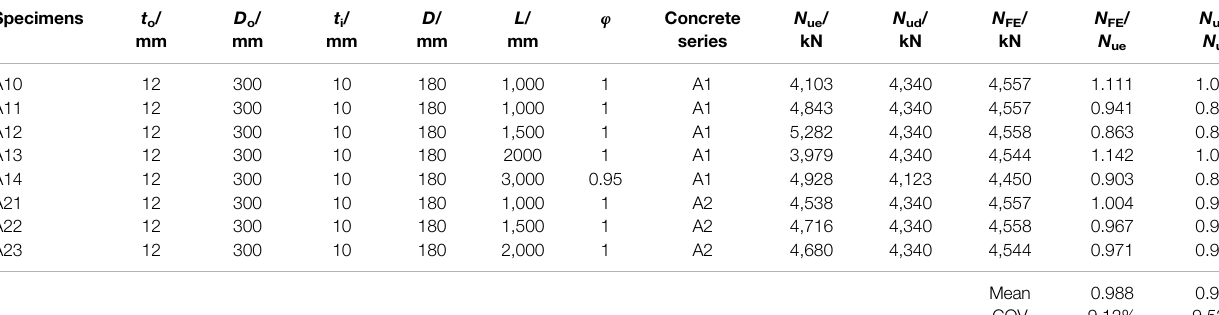
TABLE 5 | Comparison of ultimate